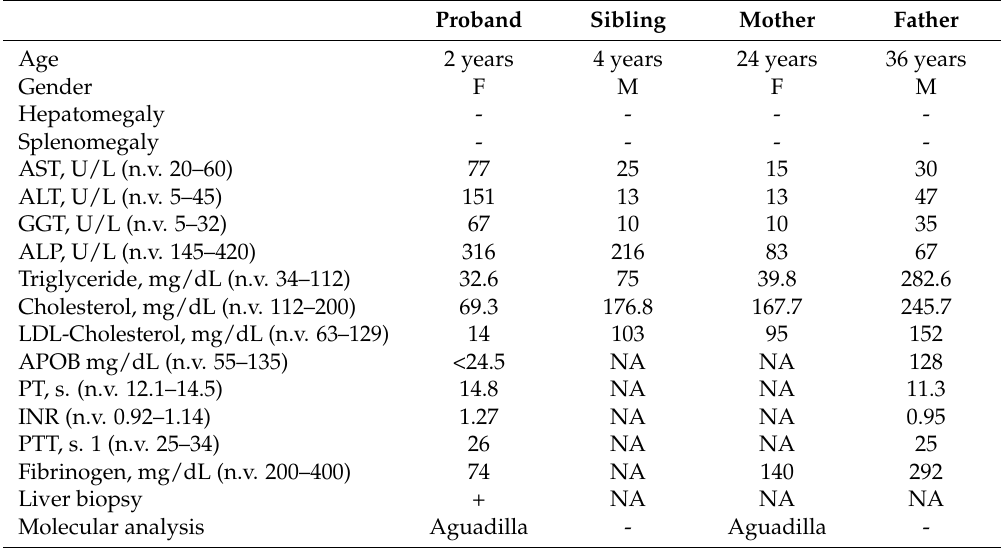
Table 3. Proband’s family studies: main clinical, biochemical, and molecular genetics results. Proband Sibling Mother Father 2